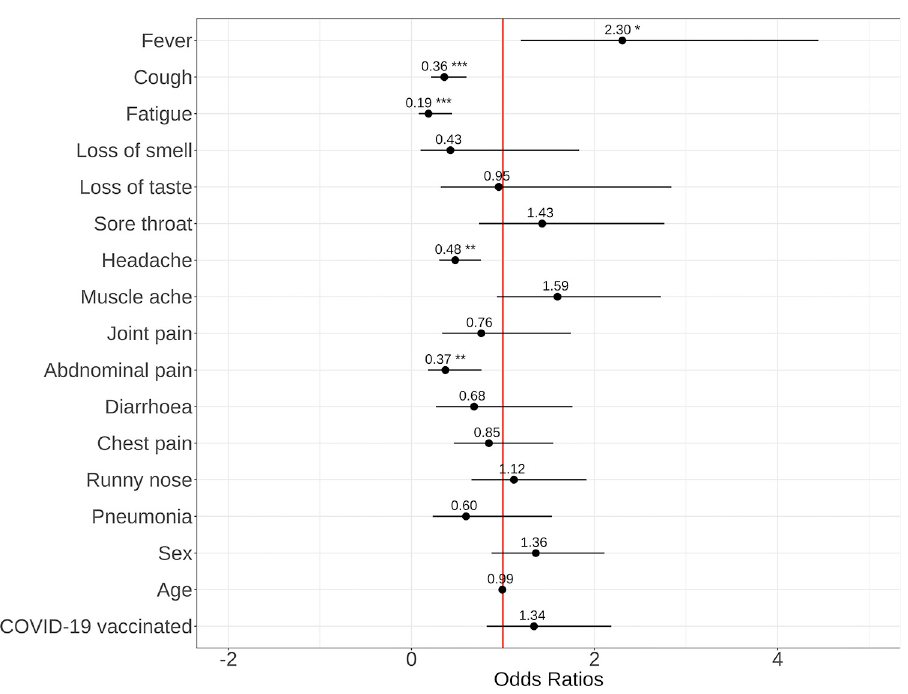
Fig 2. Clinical symptoms associated with PCR-confirmed SARS-CoV-2 infection. Differences in clinical symptoms of PCR-confirmed SARS-CoV-2 infected adults during the Omicron and Pre-Omicron phases (n = 447).